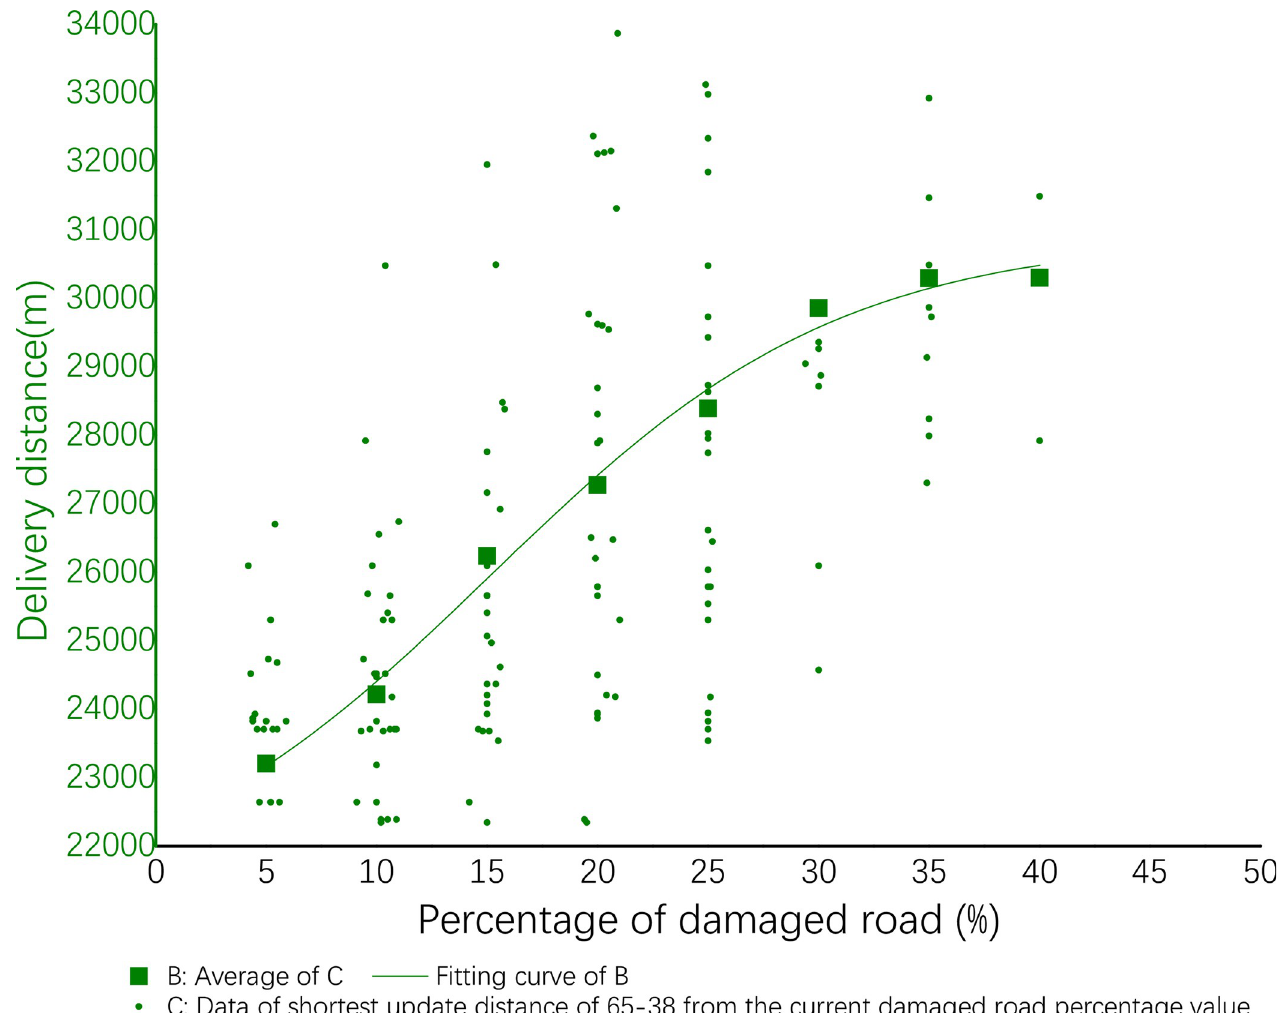
Fig 6. Delivery efficiency of 65–38.